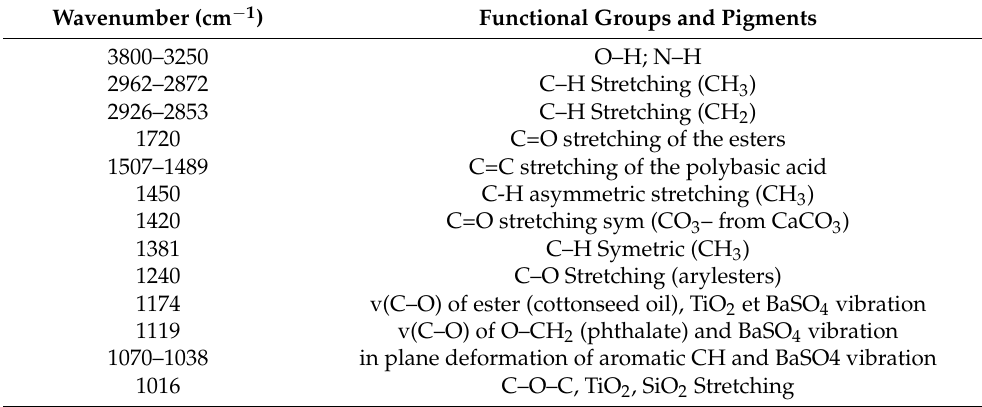
Table 7. FTIR-ATR infrared absorption of white paint used in tested